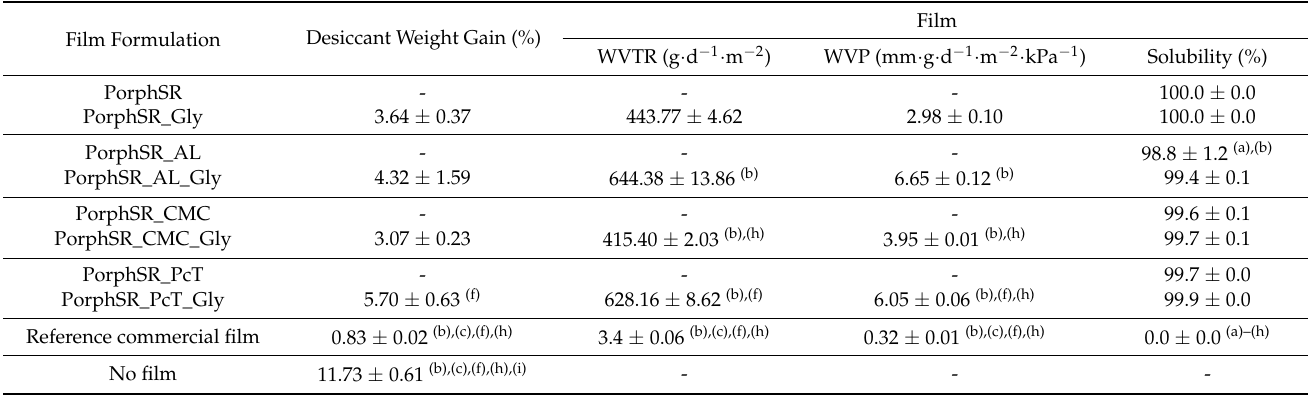
Figure 8. Water barrier effect: cumulative desiccant mass gain ( G ) over time for the produced materials and for the reference commercial film. The curve attained for uncovered silica gel is also shown. The steady-state slope of each curve was used to calculate the corresponding material WVTR (Equation (3)). Table 4. Water vapor barrier properties and water solubility of the tested